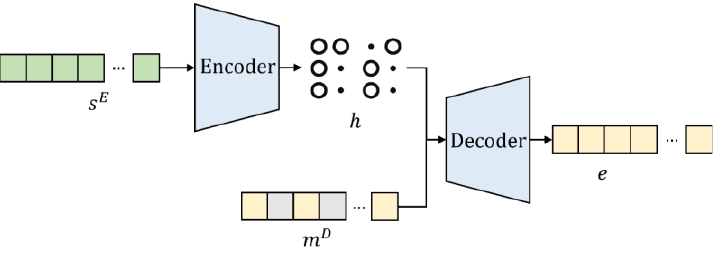
Figure 7. Seq2Seq model trainer for the training phase.